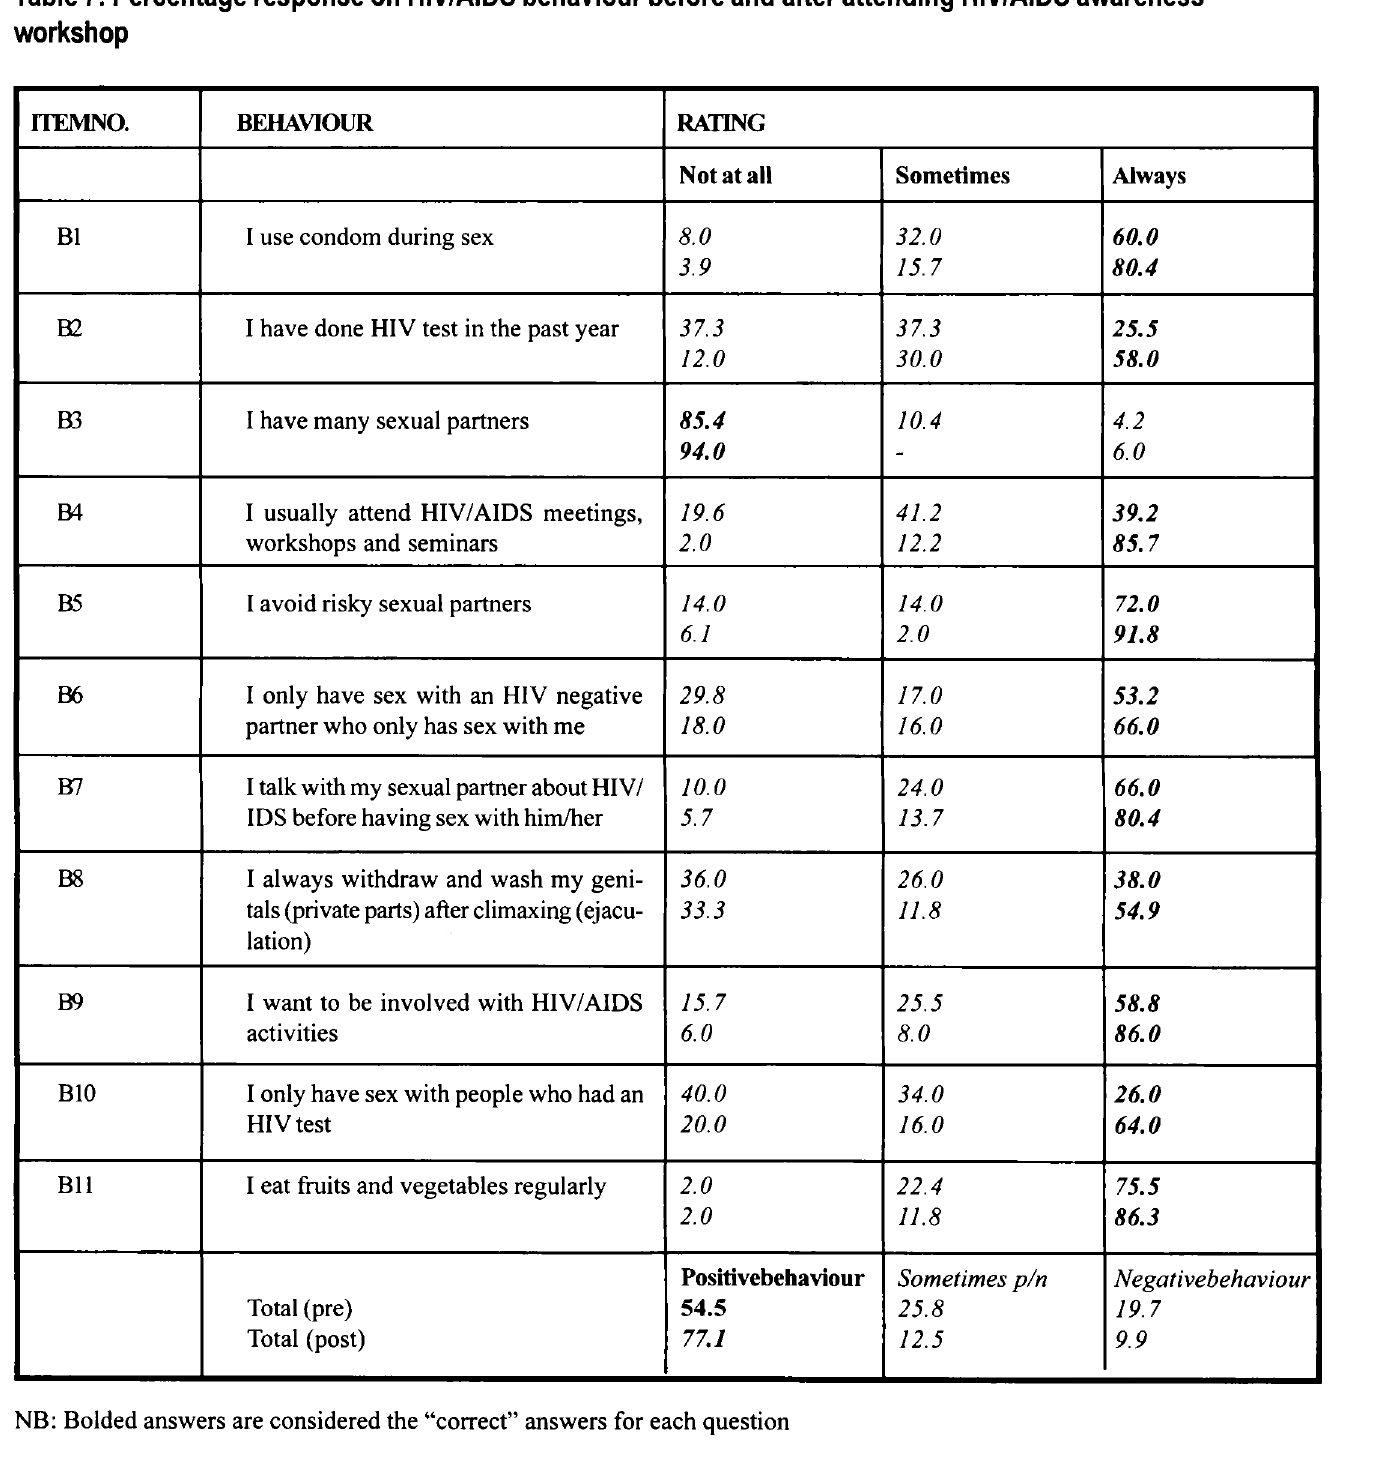
Table 7: Percentage response on HIV/AIDS behaviour before and after attending HIV/AIDS awareness workshop